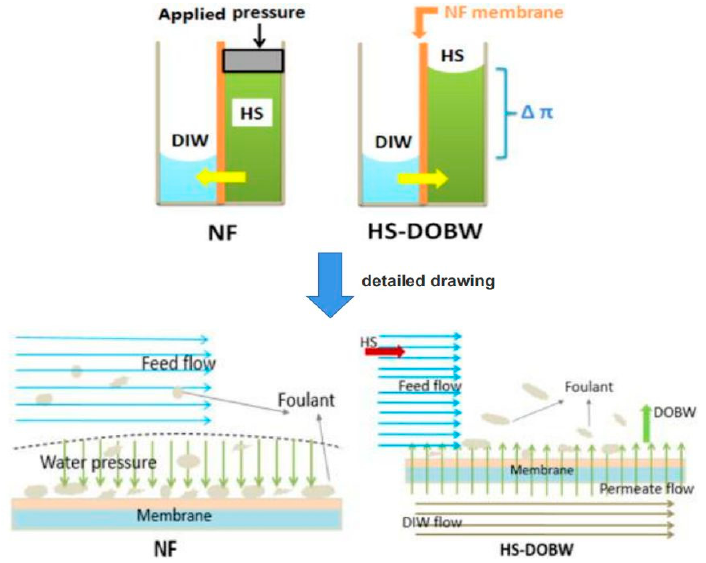
Figure 4. Schematic of NF membrane fouling and HS-DOBW cleaning. Reproduced with permission from Reference [115]. Copyright 2015, Elsevier.